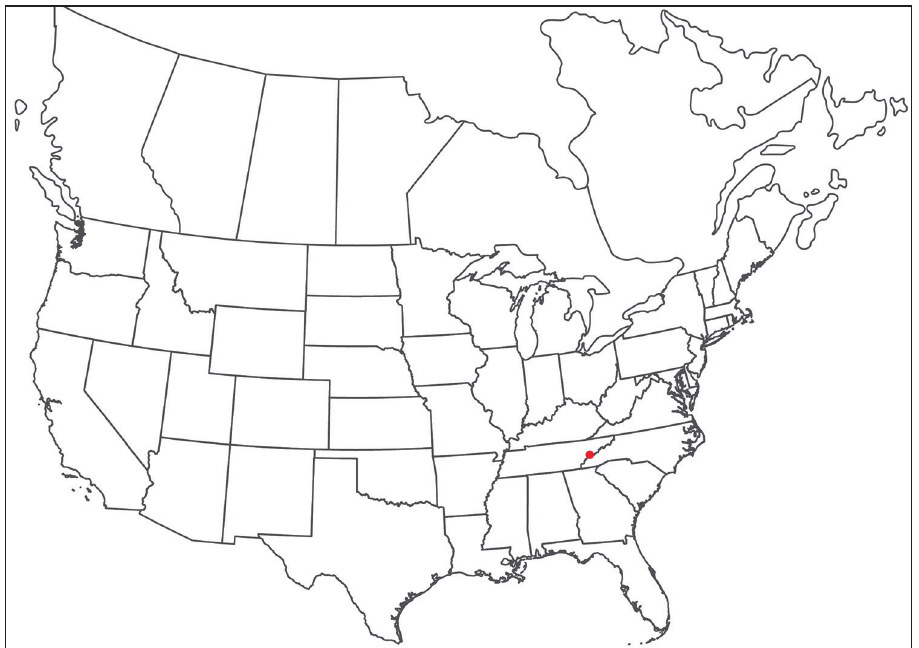
Figure 108. Torrenticola karambita sp. n.